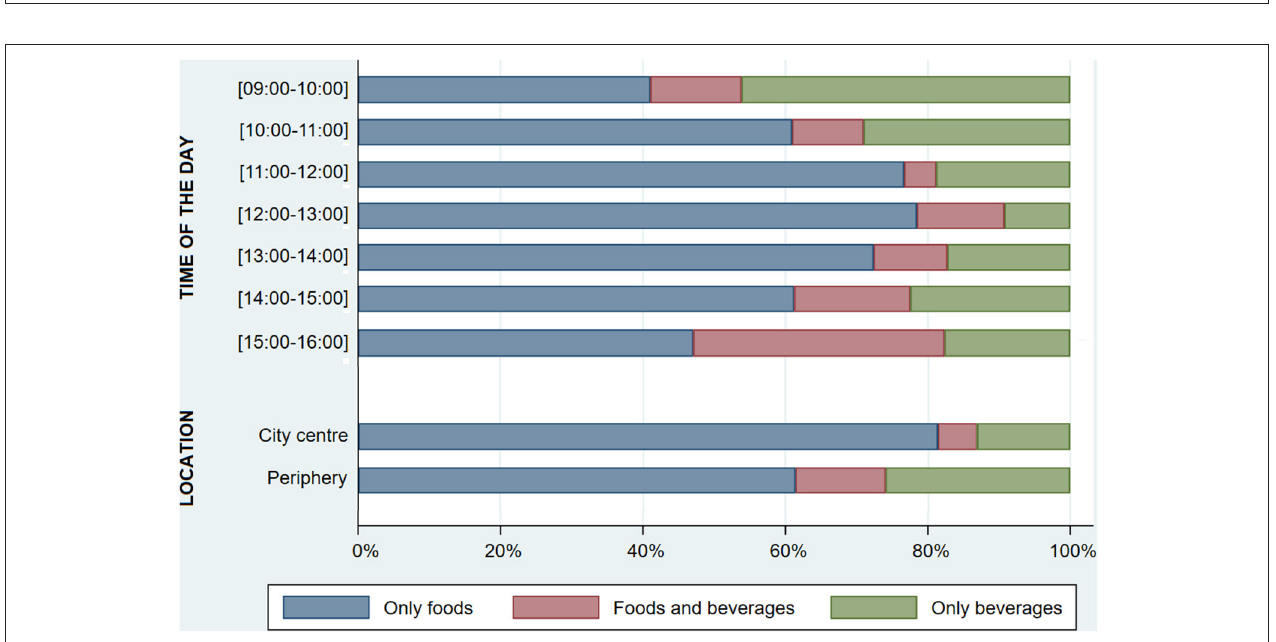
FIGURE 4 | Proportion of customers purchasing foods and/or beverages, throughout the day and by city location ( n = 714).